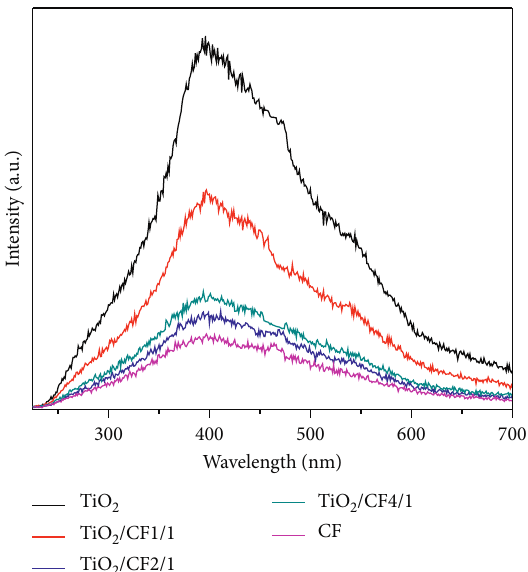
Figure 4: PL spectra of TiO CF composites.